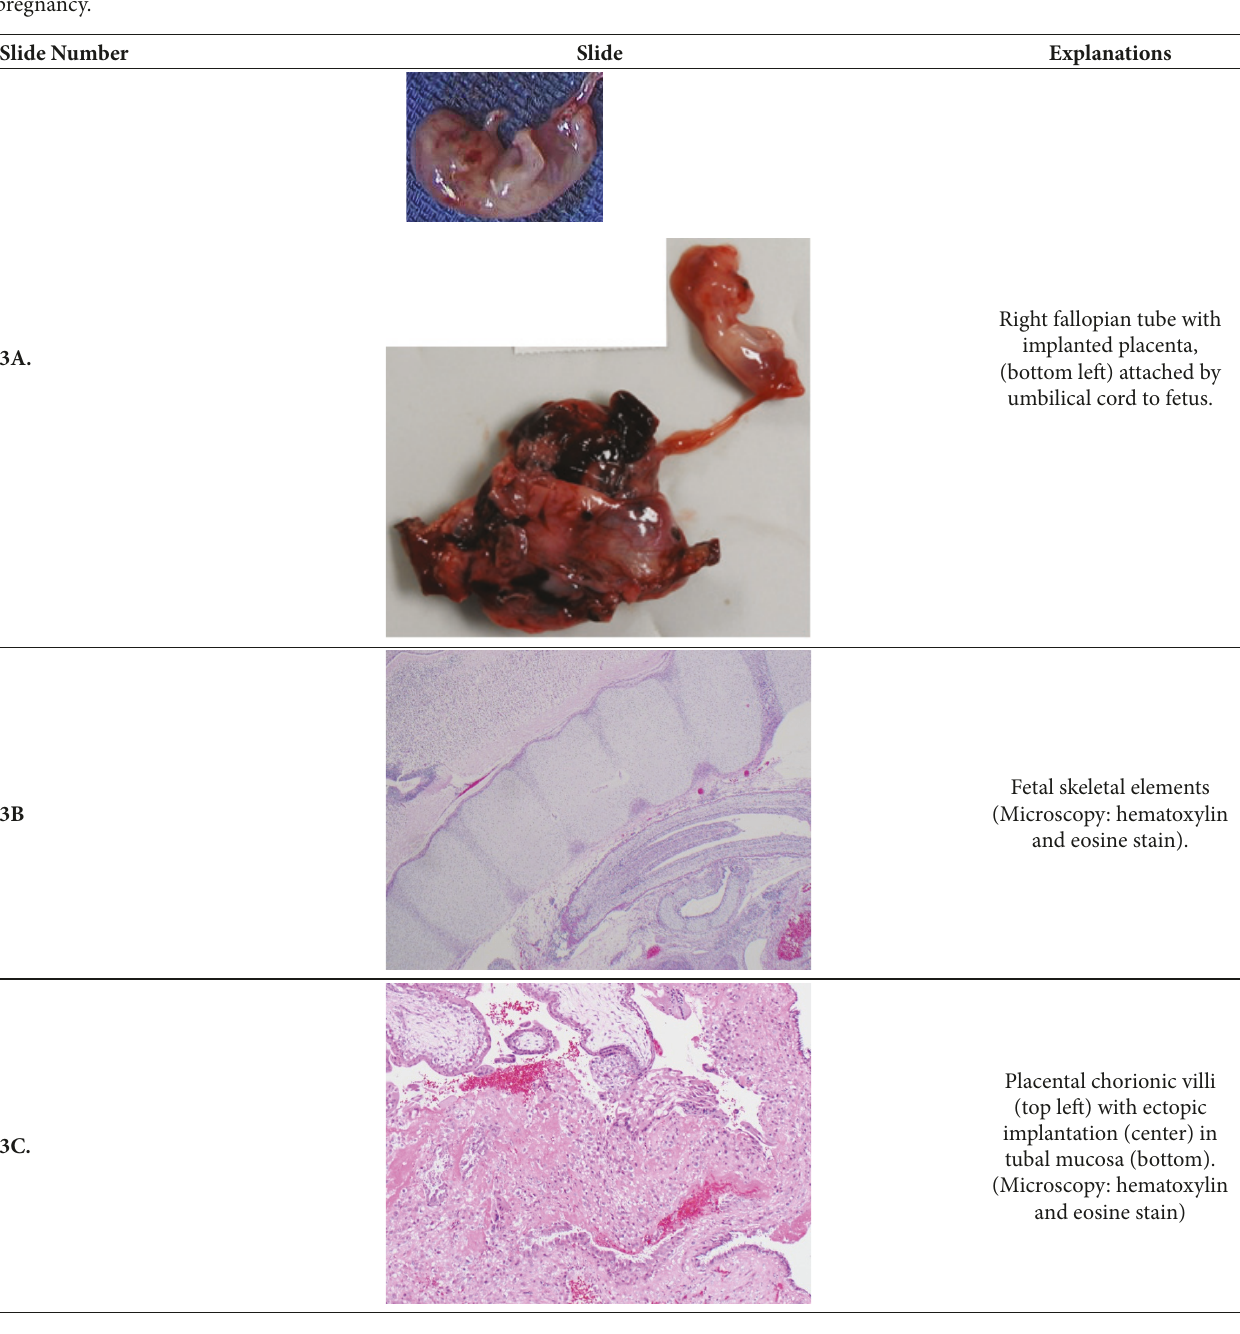
Table 1: Pathology macroscopic and microscopic images of right fallopian tube with implanted placenta and fetus, consistent with ectopic